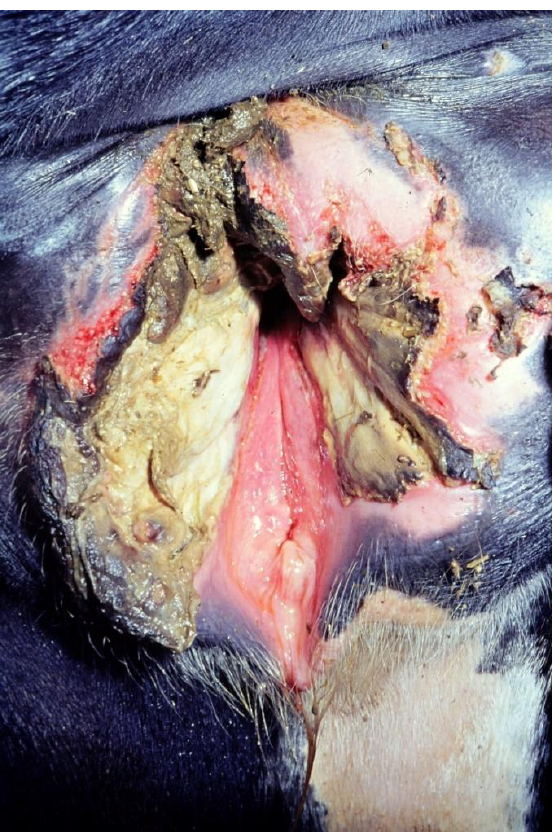
Figure 1. Injury of the vestibulum vaginae after dystocia in a heifer (picture source: Clinic for Cattle, University of Veterinary Medicine Hannover).